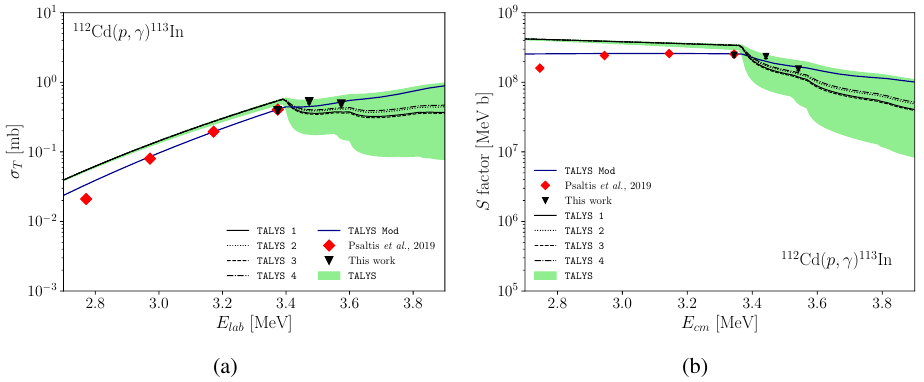
Figure 3: Total cross sections and astrophysical S factors for the reaction 112 Cd( p , γ ) 113 In (for details see